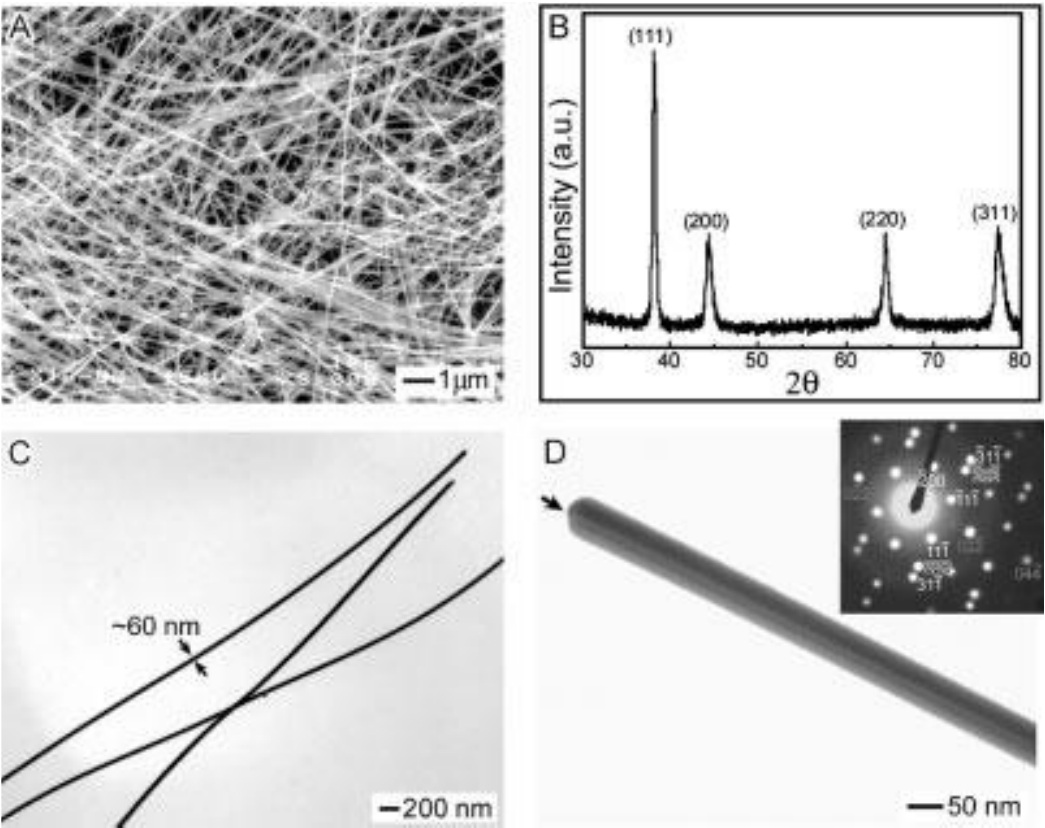
Figure 3. ( A ) Scanning electron microscopy (SEM) and ( C ) transmission electron microscopy (TEM) image of homogeneous AgNWs prepared using polyol method, ( B ) X-ray diffraction (XRD) pattern indicating face centered cubic (fcc) structure, and ( D ) TEM image showing the twin plane of single AgNWs and microdiffraction pattern (inset) [43].